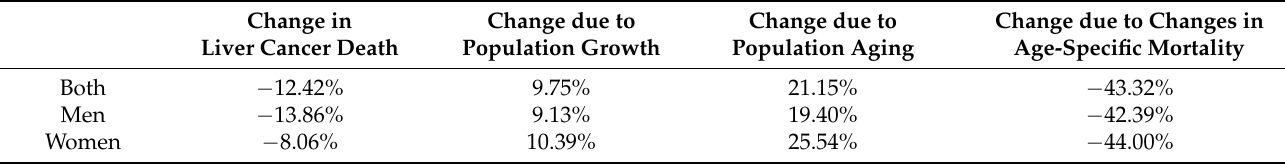
Table 2. The effects of population growth, population aging, and the age-specific mortality rate on the change in liver cancer